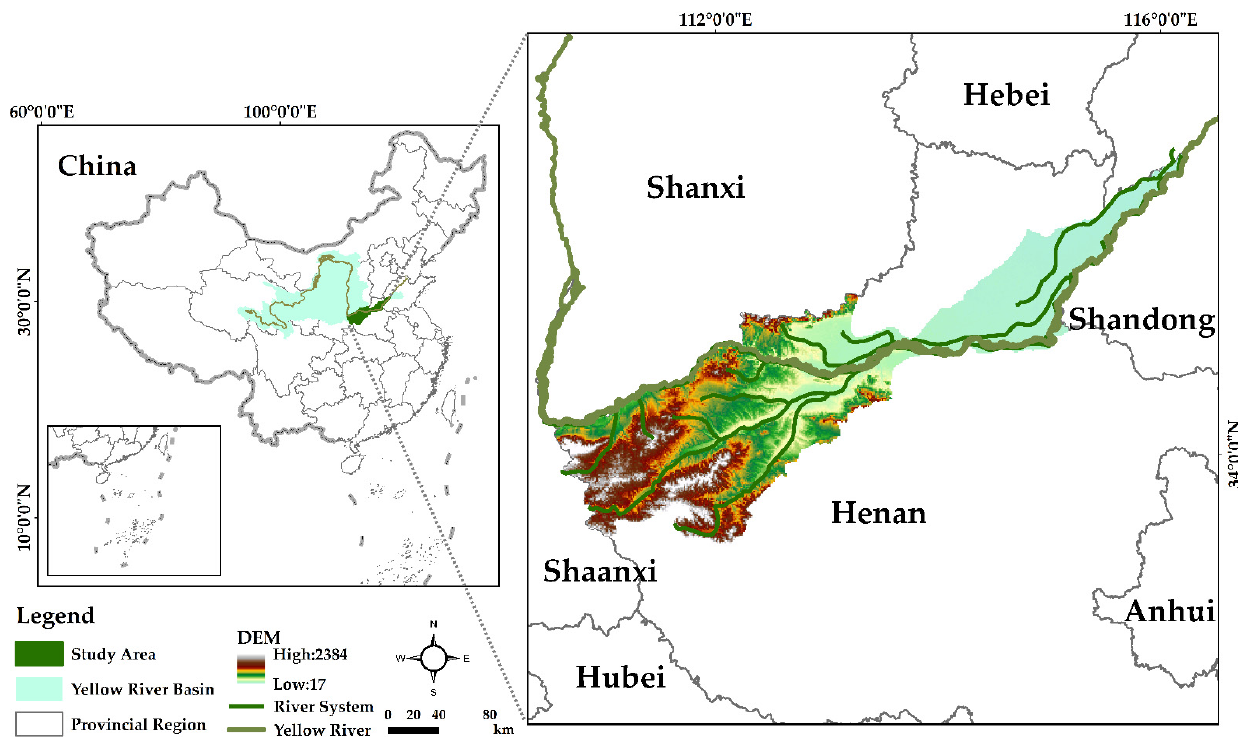
Figure 1. Schematic diagram of the Yellow River Basin (Henan section).